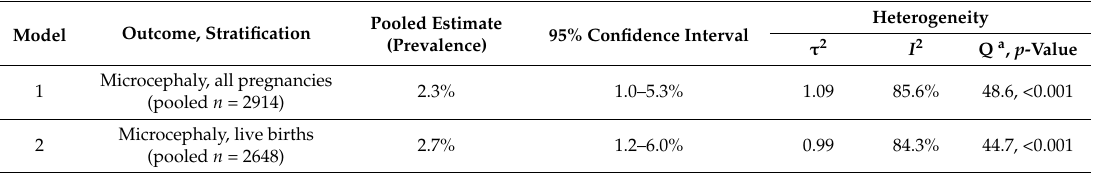
Table 2. Meta-analysis results summary.